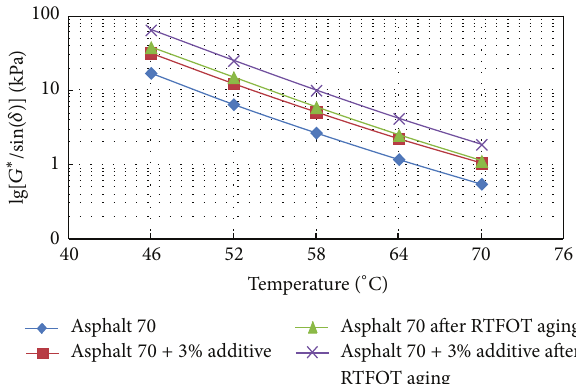
Table 4: 𝜓 , 𝜇 , and 𝛽 of virgin asphalt 70# and asphalt 90#.